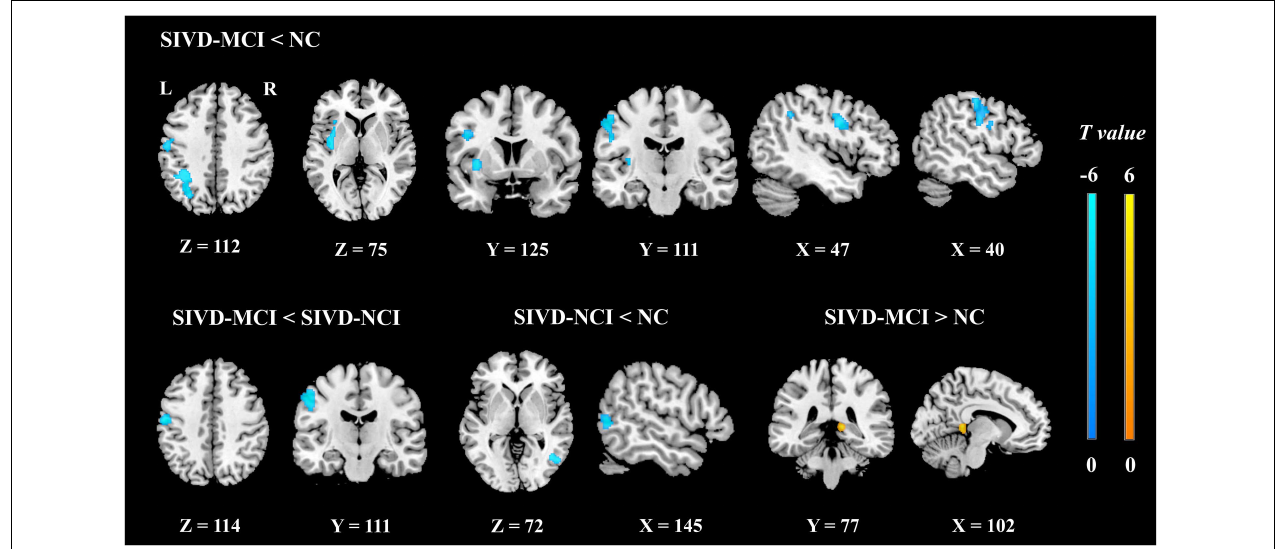
FIGURE 3 | The post hoc analyses of ReHo/CBF ratio values between each pair of groups controlling for age, gender, and education (cluster-level P < 0.05, FDR corrected, cluster-forming threshold at voxel-level P < 0.001); x , y , z , coordinates of primary peak locations in the MNI space. The color bars represent the T